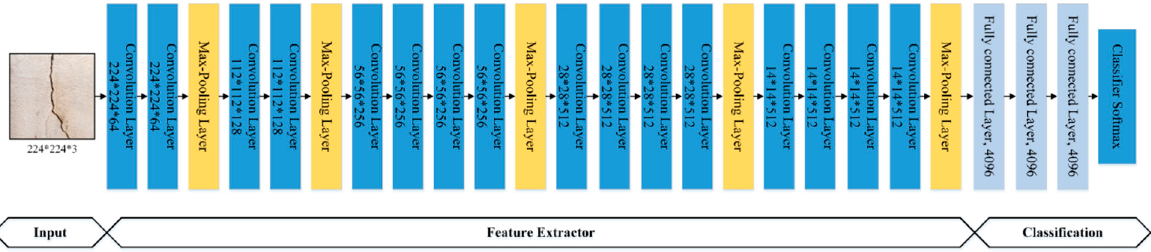
Figure 5. The architecture of the VGG-19 model.